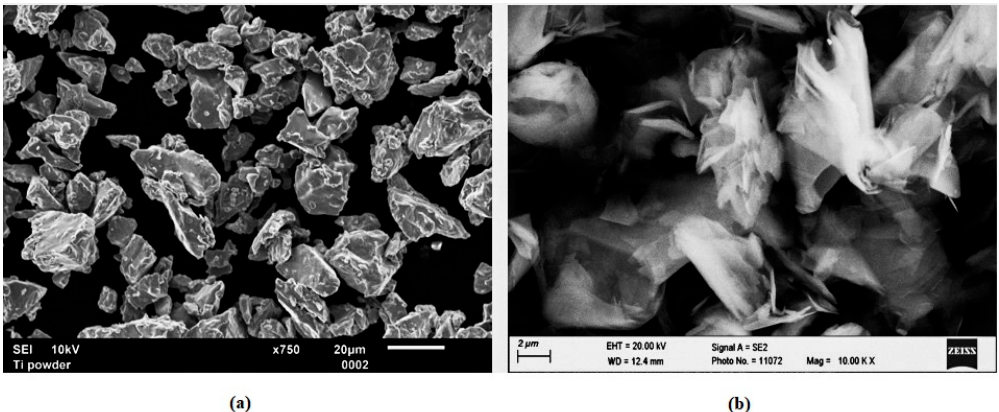
Figure 1. Characteristic shape of used HDH titanium powder and graphite: ( a ) HDH Ti powder particles at the magnification of 750 × , ( b ) graphite flakes at the magnification of 10.00k × .